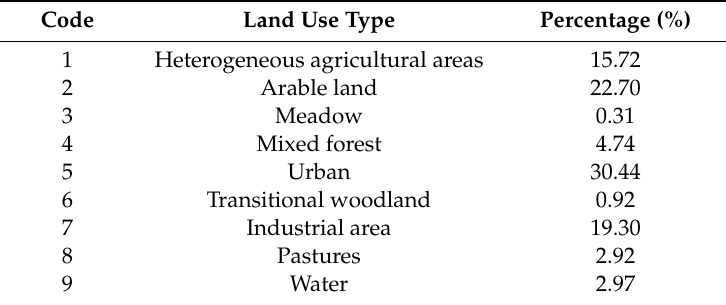
Table 2. Land use classes for the Ljubljansko polje